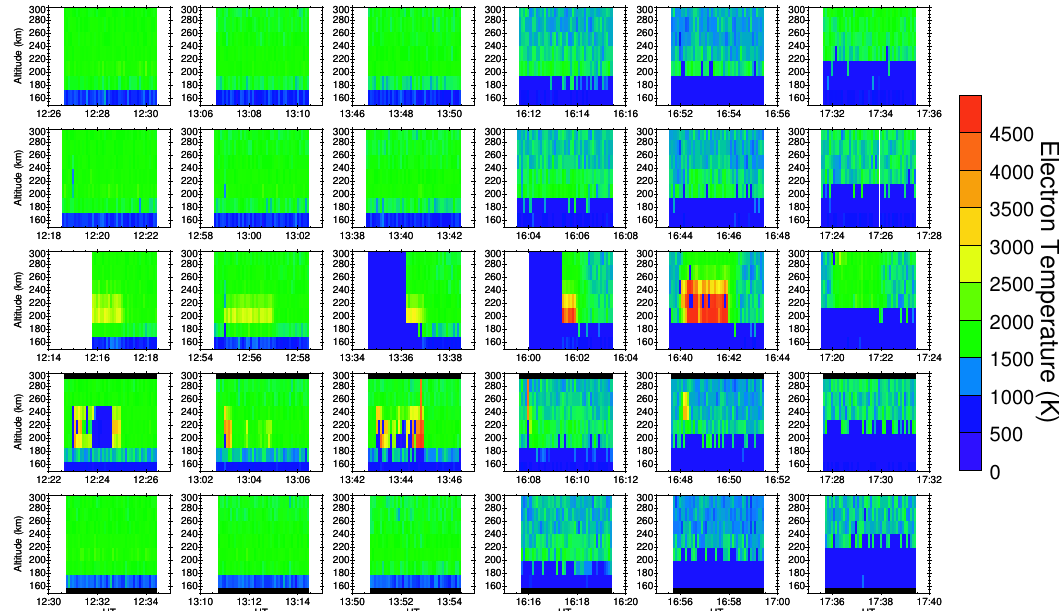
Heater = FA and UHF = FA+12, FA+6, FA, FA-6 and FA-12: 26/9/2002